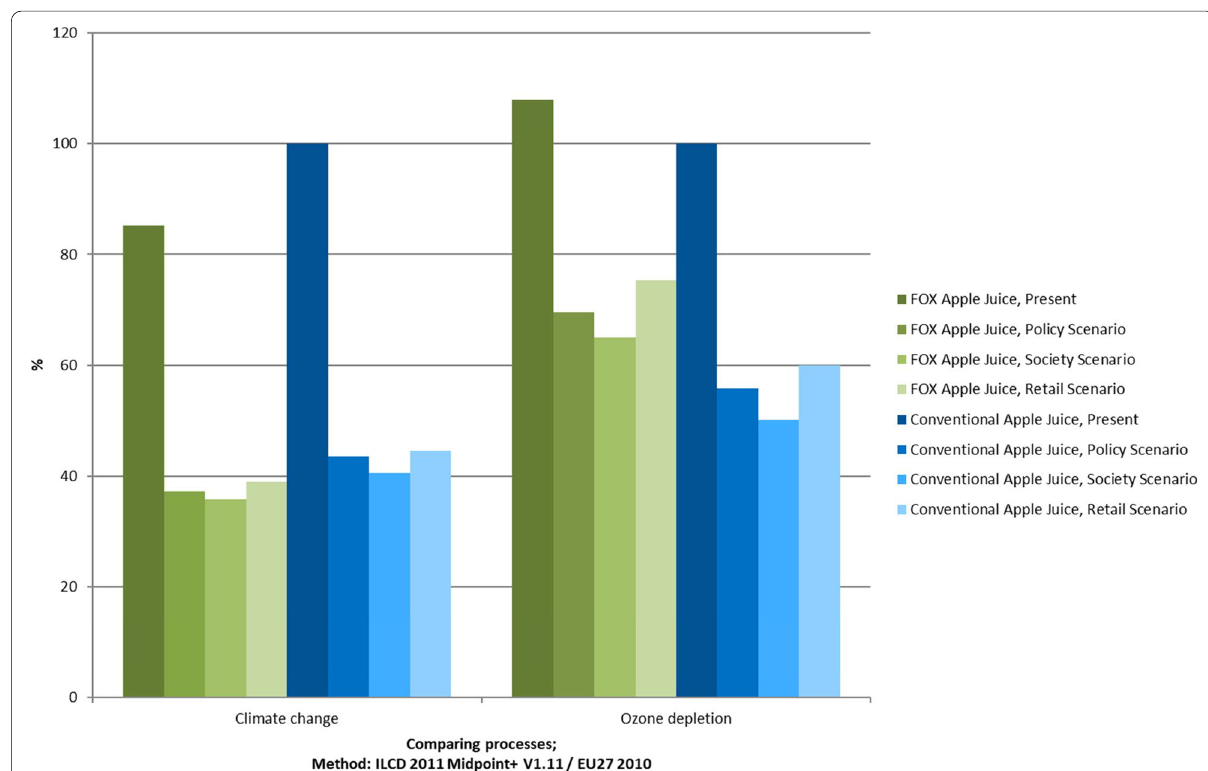
Fig. 3 Midpoint categories of FOX and conventional apple juice for the present and three future scenarios, respectively; characterized factors, method: ILCD 2011 Midpoint +